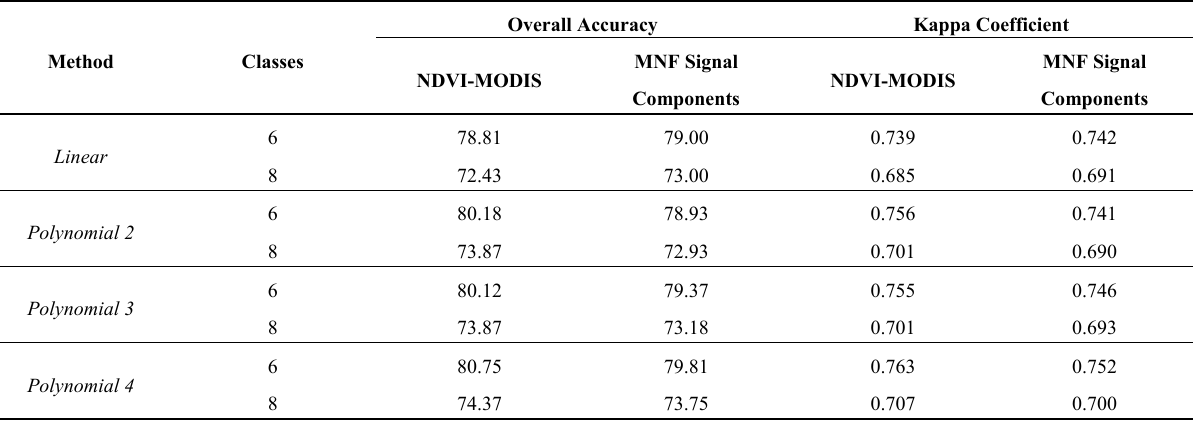
Table 6. Accuracy assessment for SVM classifications considering two types of input data (NDVI-MODIS time series and MNF signal components), main kernel function (linear, polynomial, RBF, and sigmoid), and six and eight